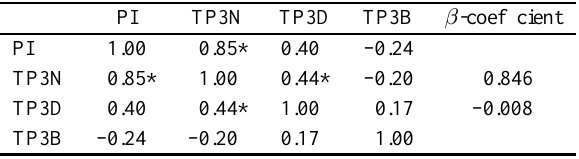
Correlation coefficients and (cid:12) -coefficients for proliferation measured with TP3 in different epidermal subpopulations PI TP3N TP3D TP3B (cid:12) -coefficient